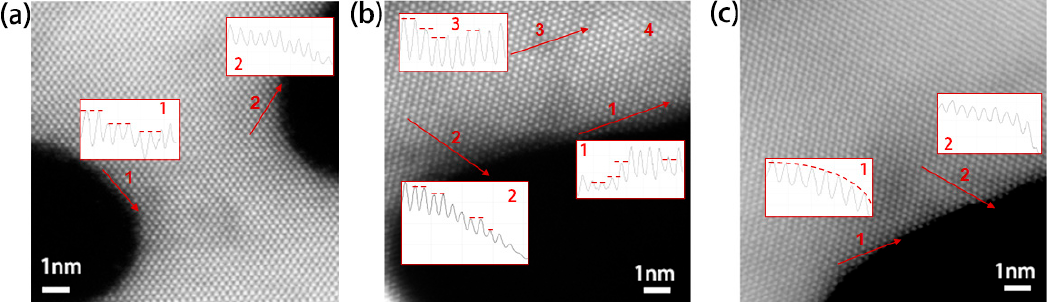
Figure 3. STEM images of the three selected samples. ( a ) NPG-Free, ( b ) NPG-1.05 V Ele, and ( c ) NPG-1.15 V Ele. The inset figures of ( a – c ) are the histograms of scattering intensity of each atomic column along arrow direction.